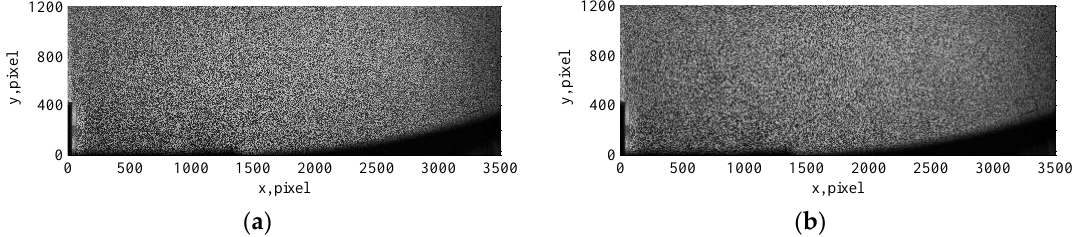
Figure 5. Raw single-shot images: ( a ) Reference (background) image (with only external flow); and ( b ) experimental image (with both external and cell nozzle flows). The figure shows the case of an overexpansion condition, with the flow direction from left to right.